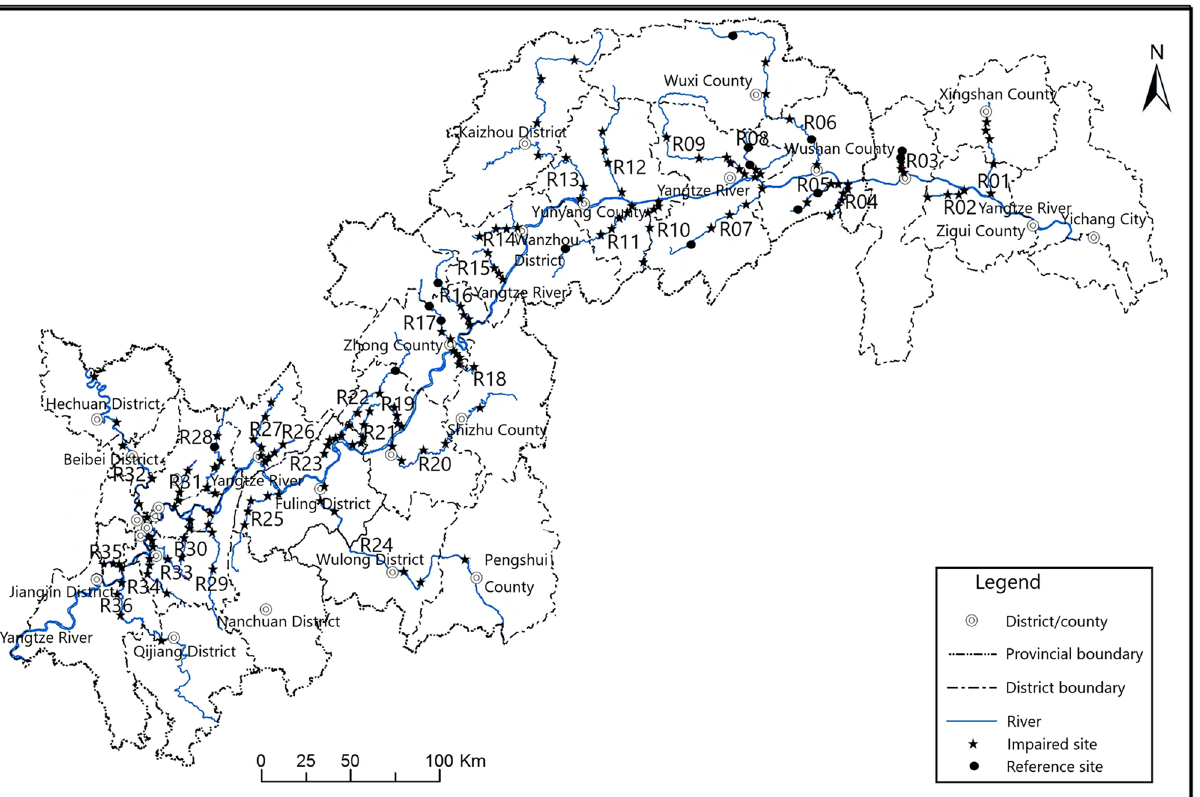
Figure 3. Schematic diagram of important tributaries of TGR and sampling points (plotted by ArcGIS 10.5, https ://www.32r.com/soft/16101